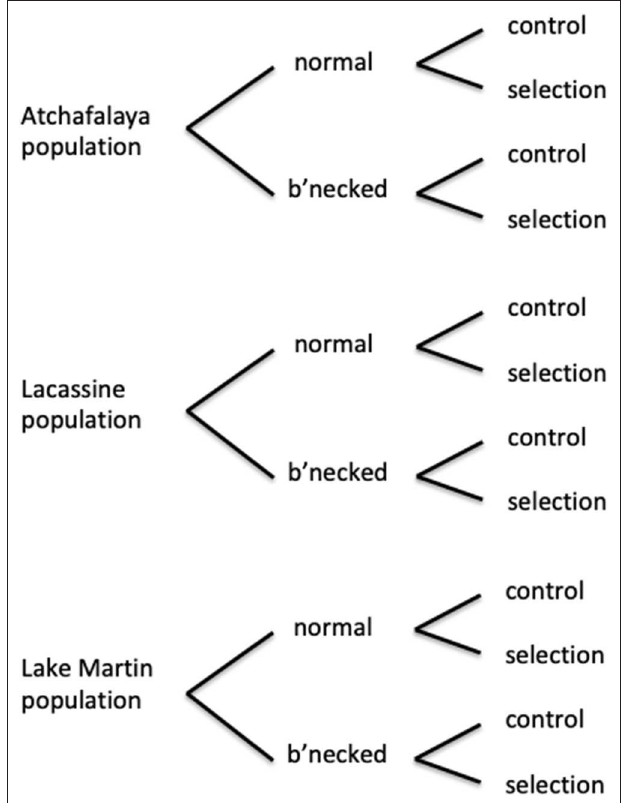
FIGURE 1 | Diagram of experimental design of selection experiments, with three source populations (each with a normal subpopulation maintained at about 120 individuals and a subpopulation passed through a single bottleneck with 2–3 individuals), and both a selection line and a control line for each of these